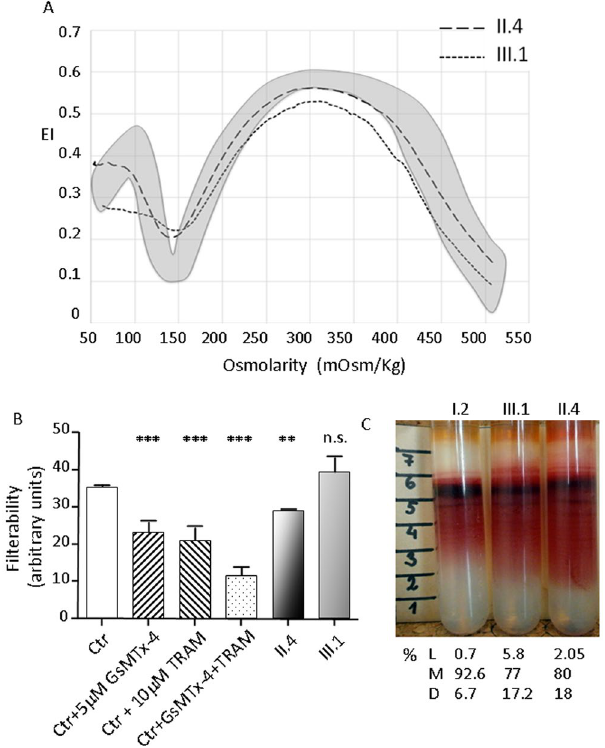
Figure 1. ( A ) LoRRca Osmoscan profile (grey area refers to 150 normal controls); ( B ) Filterabilty results; healthy cell untreated (Ctr, white bar), pre- incubated with GsMTx-4 (upward hatched bar), TRAM-34 (downward hatched bar) GsMTx-4 + TRAM-34 (dotted bar); patient II.4 (black shaded bar); patient III.1 (grey bar). All measurement were performed at least twice and significance was testes using an unpaired t-test. ** and *** denote p < 0.01 and 0.001 respectively; ( C ) Separation of RBC on Percoll density gradient and % of cells in low density (L), medium (M) and high (D) density fractions.